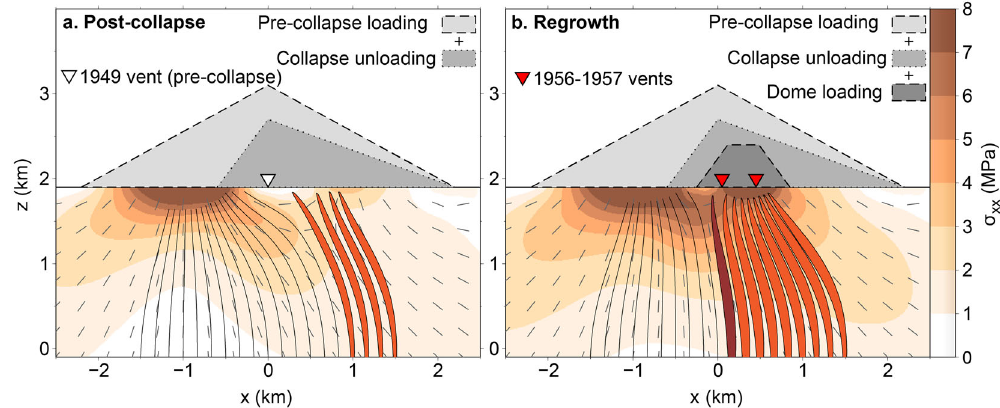
Fig. 7 Stress scenarios and simulated magma pathways on a WNW-ESE vertical cross-section of Bezymianny. The colored contours represent the horizontal stress owing to the unloading and reloading force distributions that simulate the effect of edi fi ce collapse and regrowth, respectively (gray triangles and trapezoid shades, respectively). Gray dashes indicate the direction of maximum compression. The trajectories and the shape of magmatic intrusions are plotted in red when they are de fl ected toward the collapse embayment. Magma pathways that converge toward the rim of the collapse scarp are marked by solid black lines. a Post-collapse scenario: the pre-collapse vent location (white reverse triangle), appears to be inhibited (paths diverge to both sides away from it). The most favorable position for post-collapse vents is within the collapse embayment (red trajectories), because of collapse unloading forces. New vents may be shifted up to several hundreds of meters towards the collapse direction. b Regrowth scenario: more paths are de fl ected toward the collapse embayment, and they tend to converge toward the center of the loading force distribution associated with the new dome (gray trapezoid). Even though the compressive stress below the collapse embayment is increased by the new dome, it is still lower than the horizontal compression underneath the rim. A region of relatively lower compressive stress (paths highlighted in dark red), may represent a more favorable location for magma paths to intrude within the new